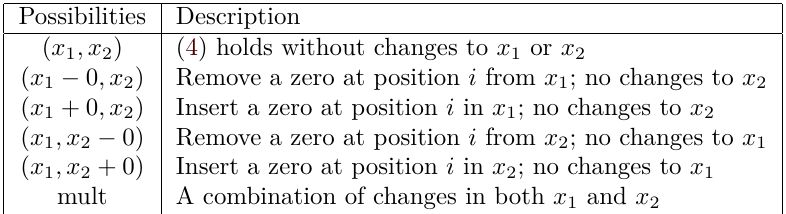
Table 1: Possible branching